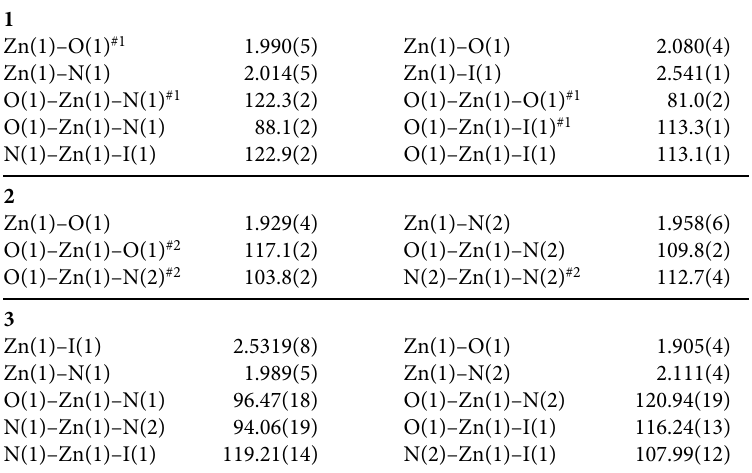
Figure 6. Molecular packing structure of complex 3 Table 2. Selected bond distances (Å) and angles (°) for the complexes